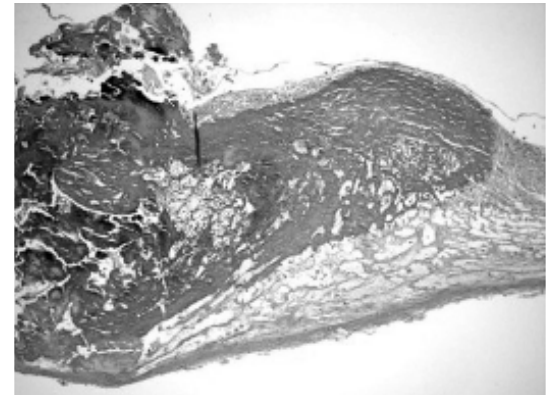
Fig. 2 – Microscopia óptica da válvula convencional (GA). Coloração por HE. Nota-se ausência de re-celularização da superfície